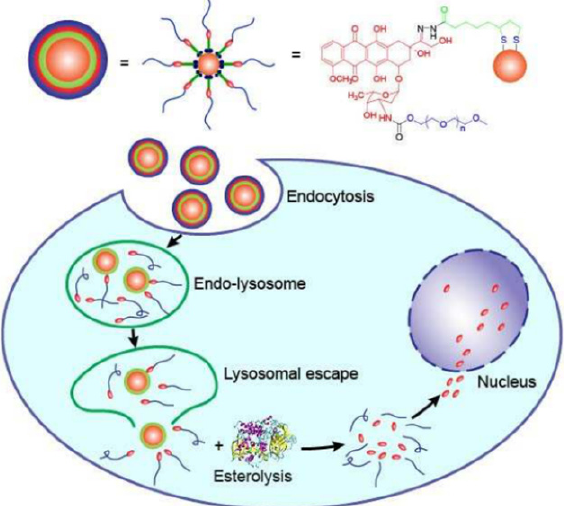
Figure 12. AuNPs are used in cancer treatment. The production and drug release mechanism of DOX-conjugated AuNPs is depicted schematically. The scheme for producing DOX-conjugated AuNPs is shown in the upper half. The lower part depicts the release of the DOX-conjugated AuNPs after endocytosis [220]. Copyright American Chemical Society